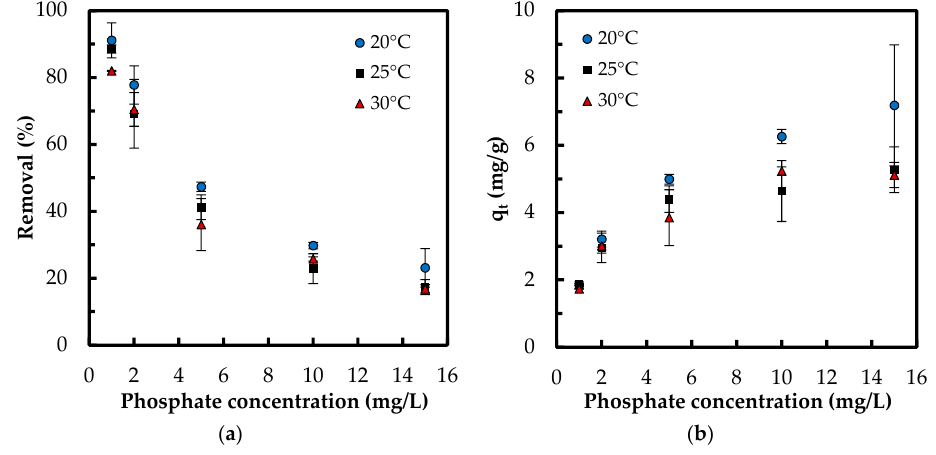
Figure 9. Effect of temperature on: ( a ) phosphate removal percentage; and ( b ) adsorption capacity (mg/g) (Experimental conditions: 0.5 g/L Zn(II)–CTS dose; pH 4; 24 h contact time).